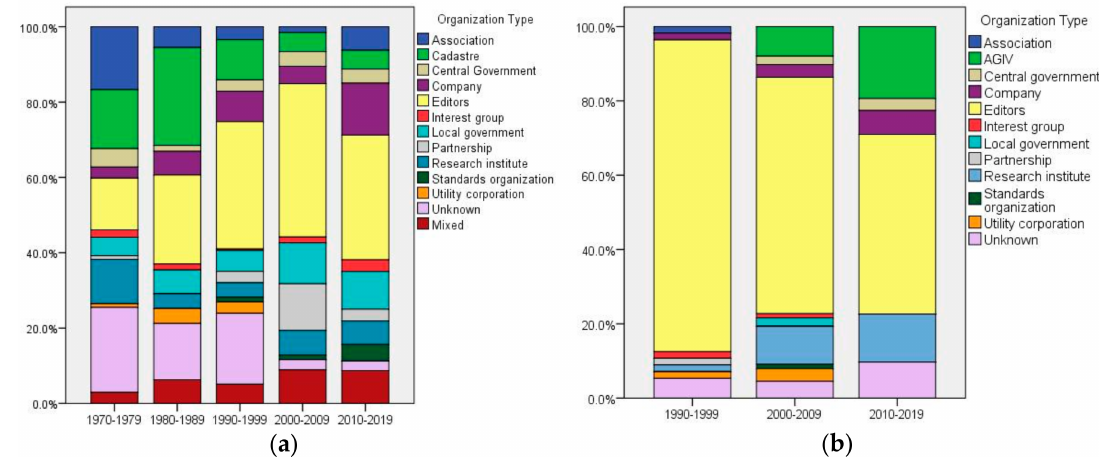
Figure 2. Relative distribution of article author affiliations, categorised into case-specific SDI groupings per decade: ( a ) distribution of BGT-related articles (The Netherlands); ( b ) distribution of GRB-related articles